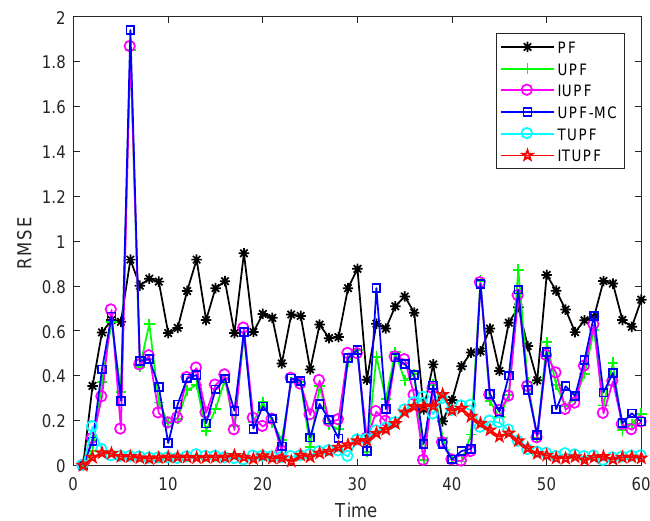
Figure 6. RMSE of different particle filters over 100 Monte Carlo runs.